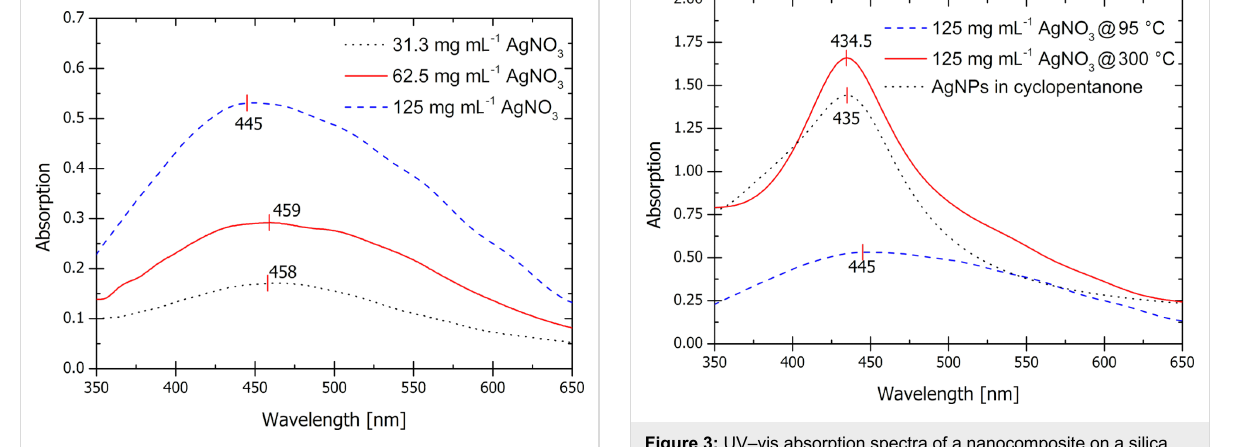
more defined with a λ max of 434.5 nm. The peak position at 434.5 nm is a typical value for the absorption band of AgNPs [17]. Also; this peak resembles the plasmonic peak obtained for AgNPs in cyclopentanone. The shoulder appearing at higher wavelengths for the nanocomposite indicates the retention of the AgNP clusters, formed during the lower temperature treat- ments. These results are visually corroborated in the SEM images shown in Figure 4.